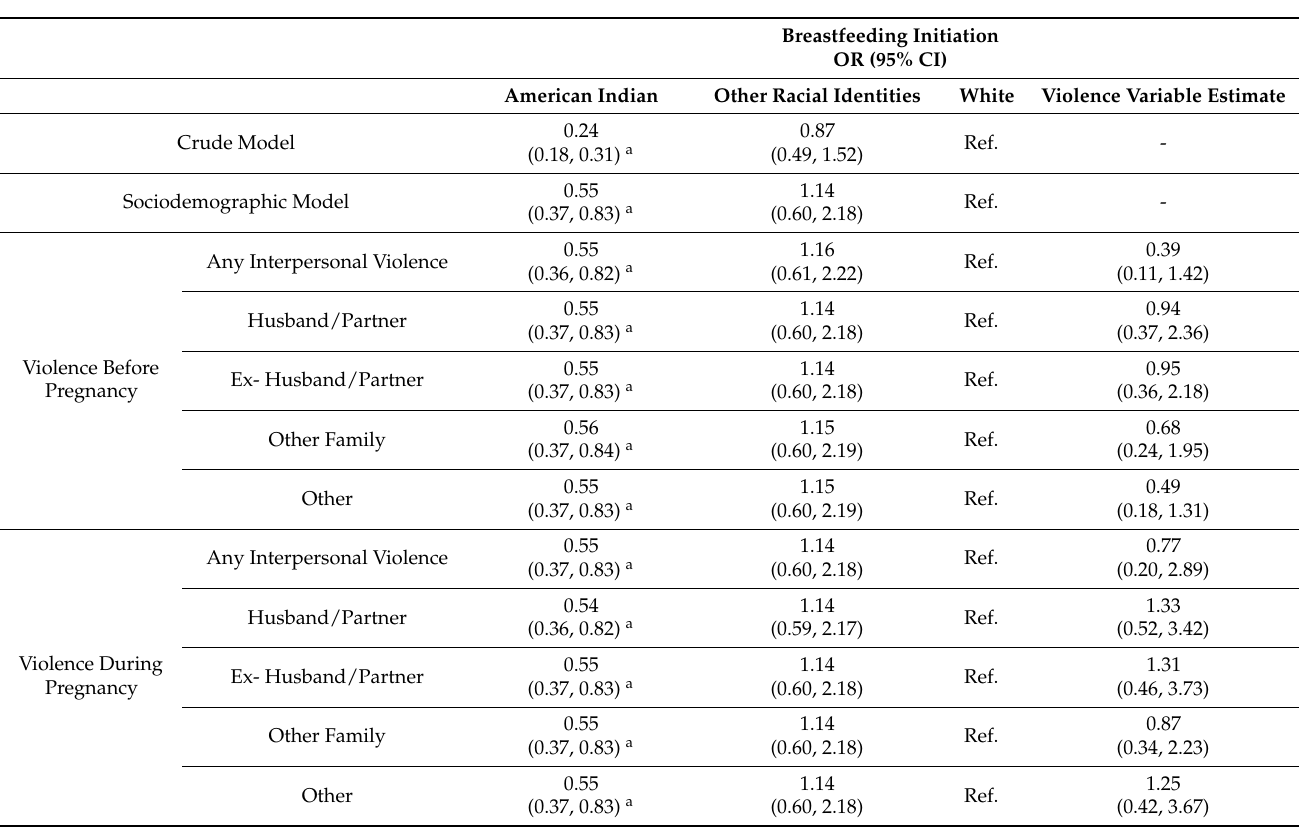
Table 3. Association between race/ethnicity and breastfeeding initiation, adjusted for violence exposure before and during pregnancy 1 .